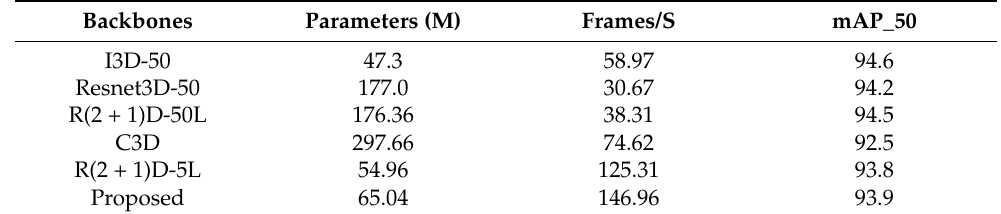
Table 2. Performance comparison of backbone architectures for action recognition of the LfD da- taset.